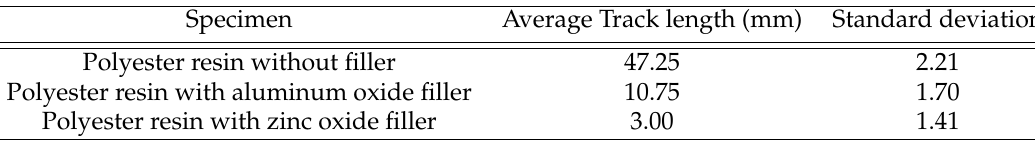
Table 3. Average track length of each specimen and standard deviation